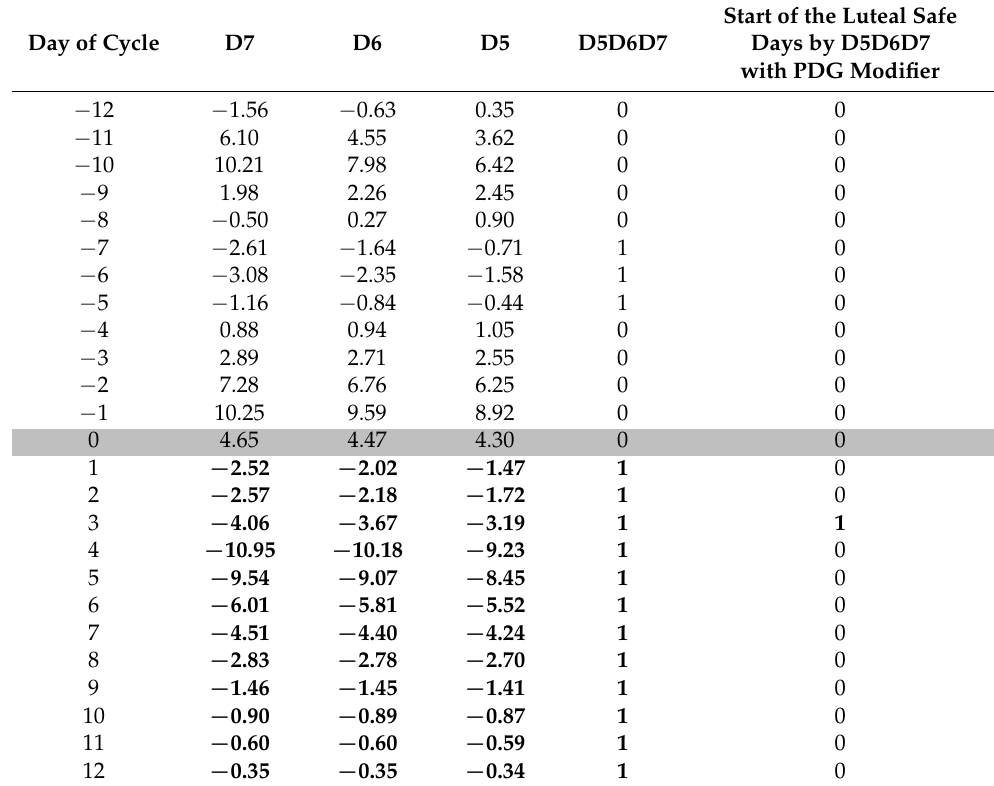
Table 1. D5D6D7 convolution analysis with application of PDG modifier for cycle 20.1